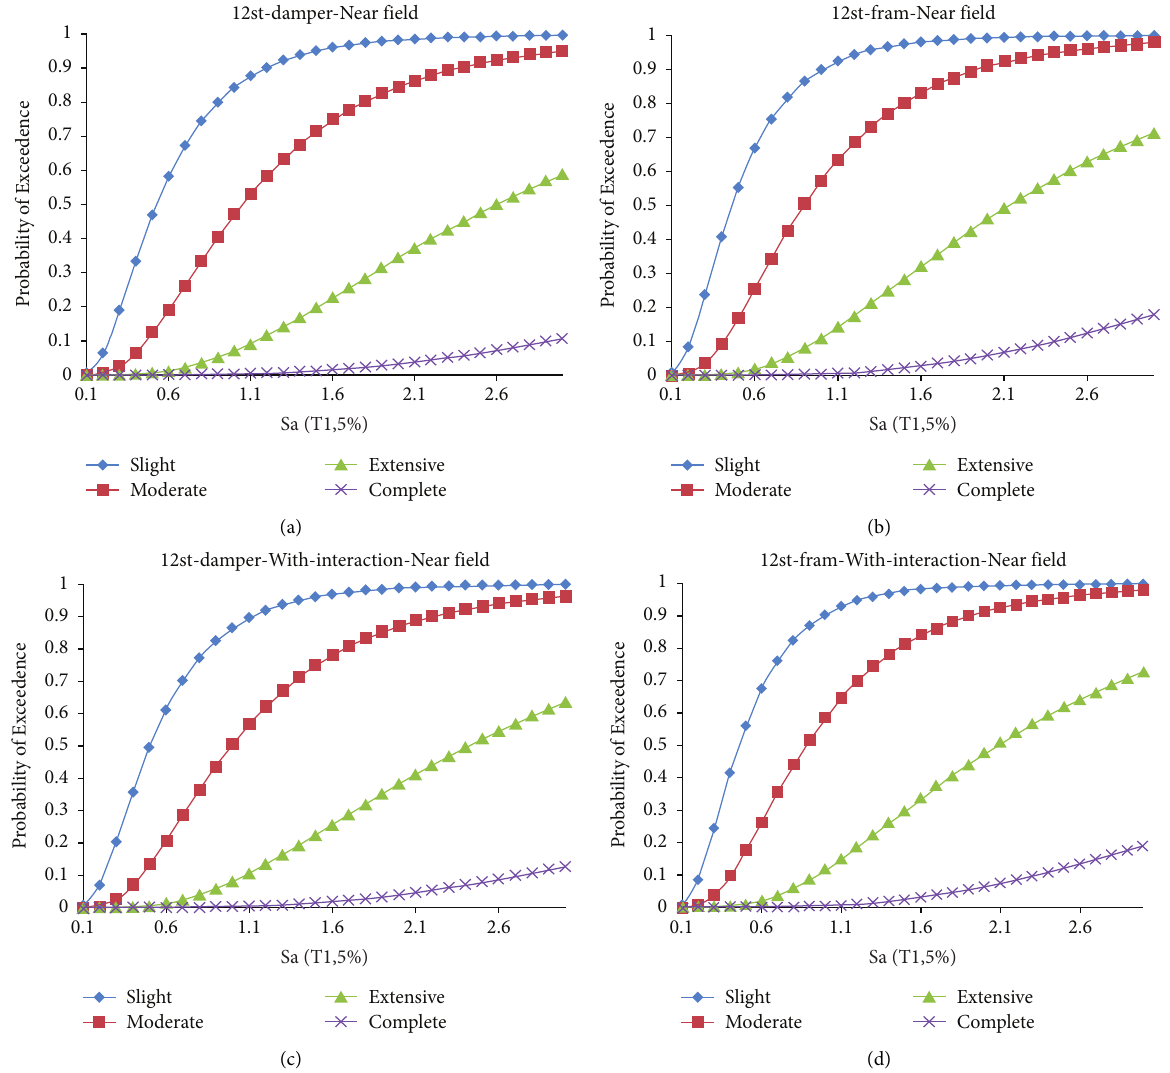
Figure 14: Fragility curves in 12-story ordinary moment resisting frame affected by near-field earthquakes. Examined cases: (a) with damper without considering SSI; (b) without damper and SSI effect; (c) with damper and considering SSI; (d) without damper but considering SSI